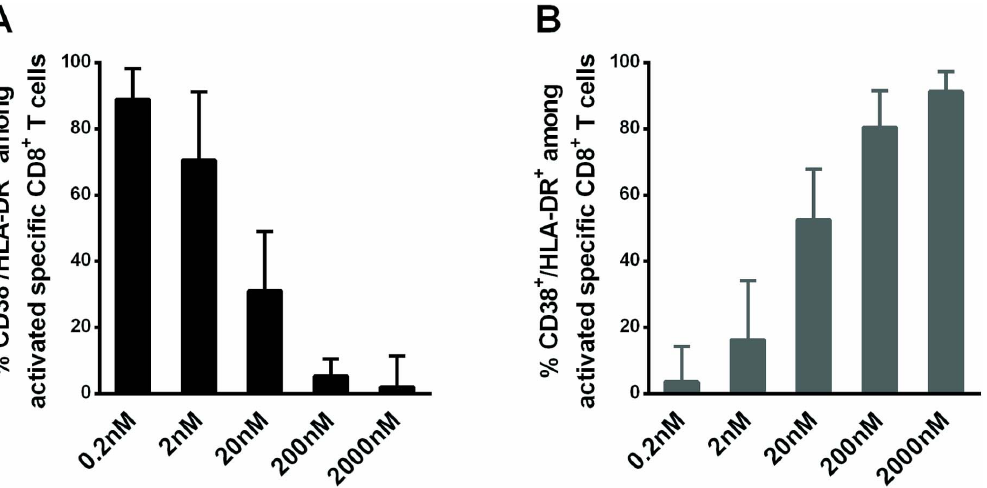
Figure 5. Stimulation with a low antigen concentration induces the CD38 2 /HLA-DR + phenotype on specific CD8 + T cells. (A) Graphs representing the frequency of (A) CD38 2 /HLA-DR + cells (dark histograms) and (B) CD38 + /HLA-DR + cells (dark gray histograms) among activated EBV- specific healthy donor CD8 + T cells (i.e. those expressing CD38 and/or HLA-DR) after a four-day culture period (n=8).